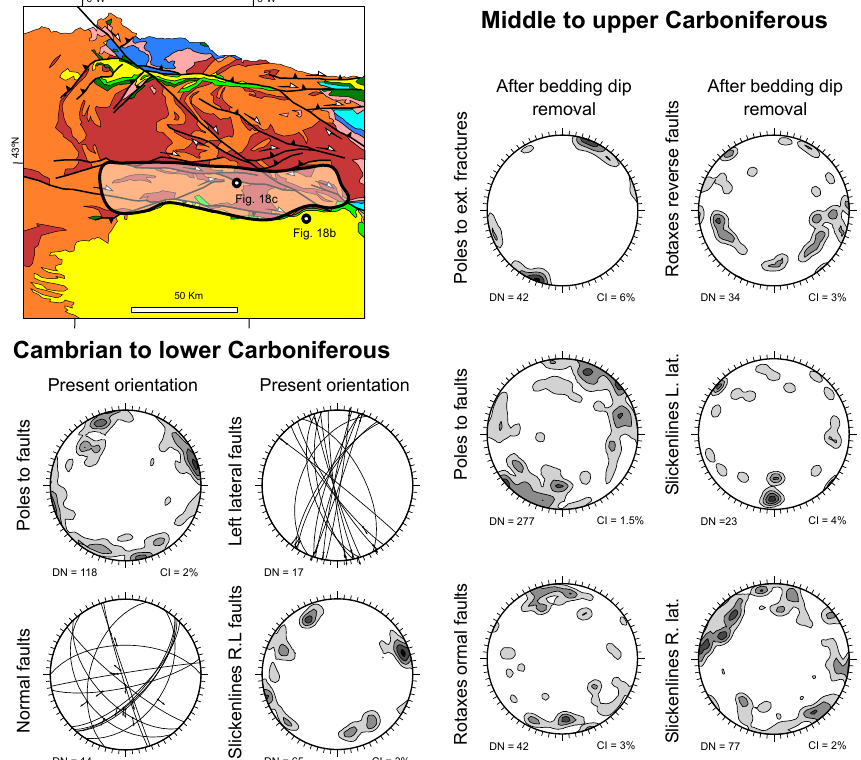
Fig. 17. Mesostructural data collected in Paleozoic rock of the Cantabrian